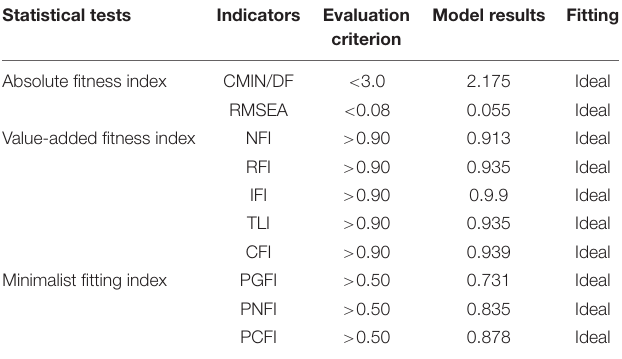
TABLE 4 | Model fitting index values.